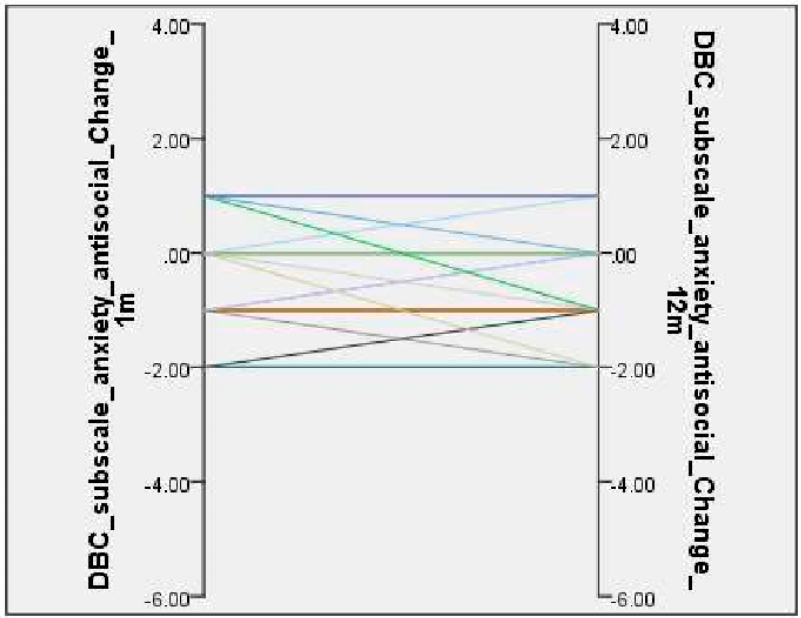
Figure A4. Scores on the Developmental Behaviour Checklist for Adults (DBC-A) subscales at baseline and at 12 months: Anxiety/Antisocial Scale.